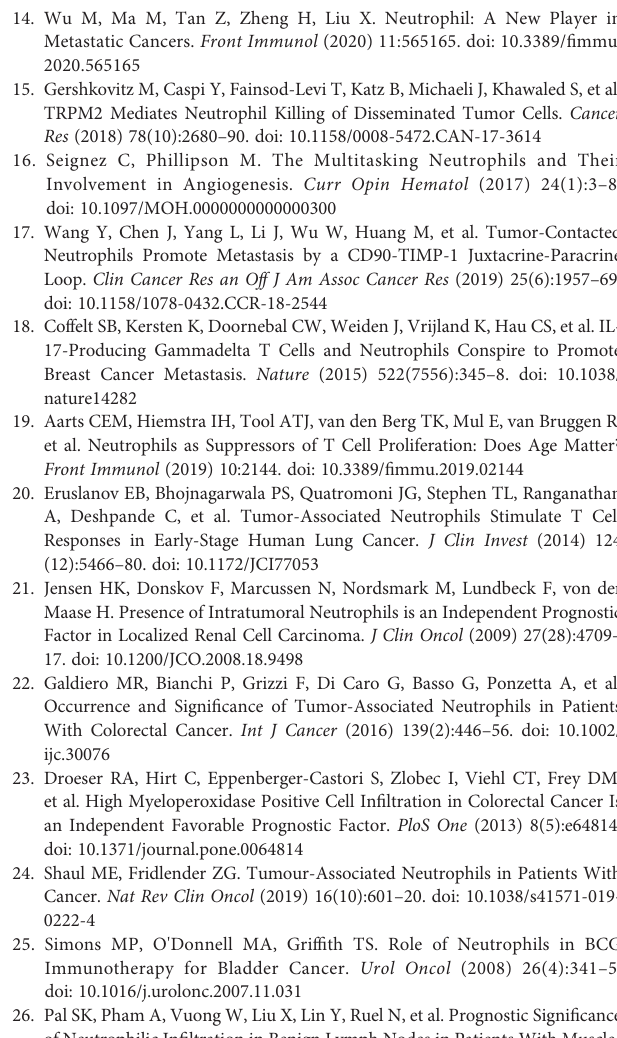
rank test. Green lines, low group; Red lines, high group. (B, C) Kaplan-Meier recurrence-freesurvivalcurvesforpatientswithUCBstrati fi edbyCD66b + INT cells (B) and CD66b + ST cells (C) . P -values were determined using the log-rank test. Black lines, low group; Red lines, high group. Supplementary Figure 2 | Kaplan-Meier overall survival curves strati fi ed by histological grade. (A) Histological LowGrade ( n =145); (B) HistologicalHighGrade ( n = 92). P -values were determined using the log-rank test. Black lines, low group; Red lines, high group. Supplementary Figure 3 | TAN and TTN phenotypes. The indicated phenotype markers were assessed using fl ow cytometry, including the adhesin marker CD62L and chemokine receptors, CXCR1 and CXCR2. (A) Expression of the indicated markers on matched CD11b + CD66b + PBNs and TANs. A single-cell suspension was obtained from freshly harvested tumor tissues and the peripheral blood of UCB patients. (B) The expression of the indicated markers was assessed on puri fi ed PBNs and TTNs. Autologous PBNs were puri fi ed from the PBMCs of healthy donors, and cultured with tumor cell line T24 supernatants,